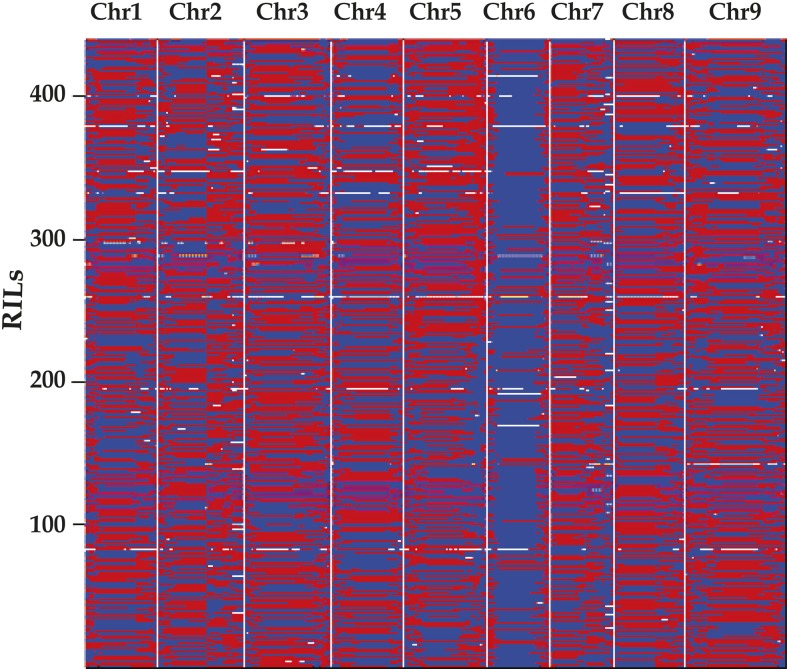
Recombination bin map constructed using high quality SNPs from sequencing genotyping of the RIL population. Whole map of 2024 recombination bins for the 439 RILs. Chromosomes are separated by vertical gray lines. Chr, chromosome; RIL, recombinant inbred line; SNP, single nucleotide polymorphism.